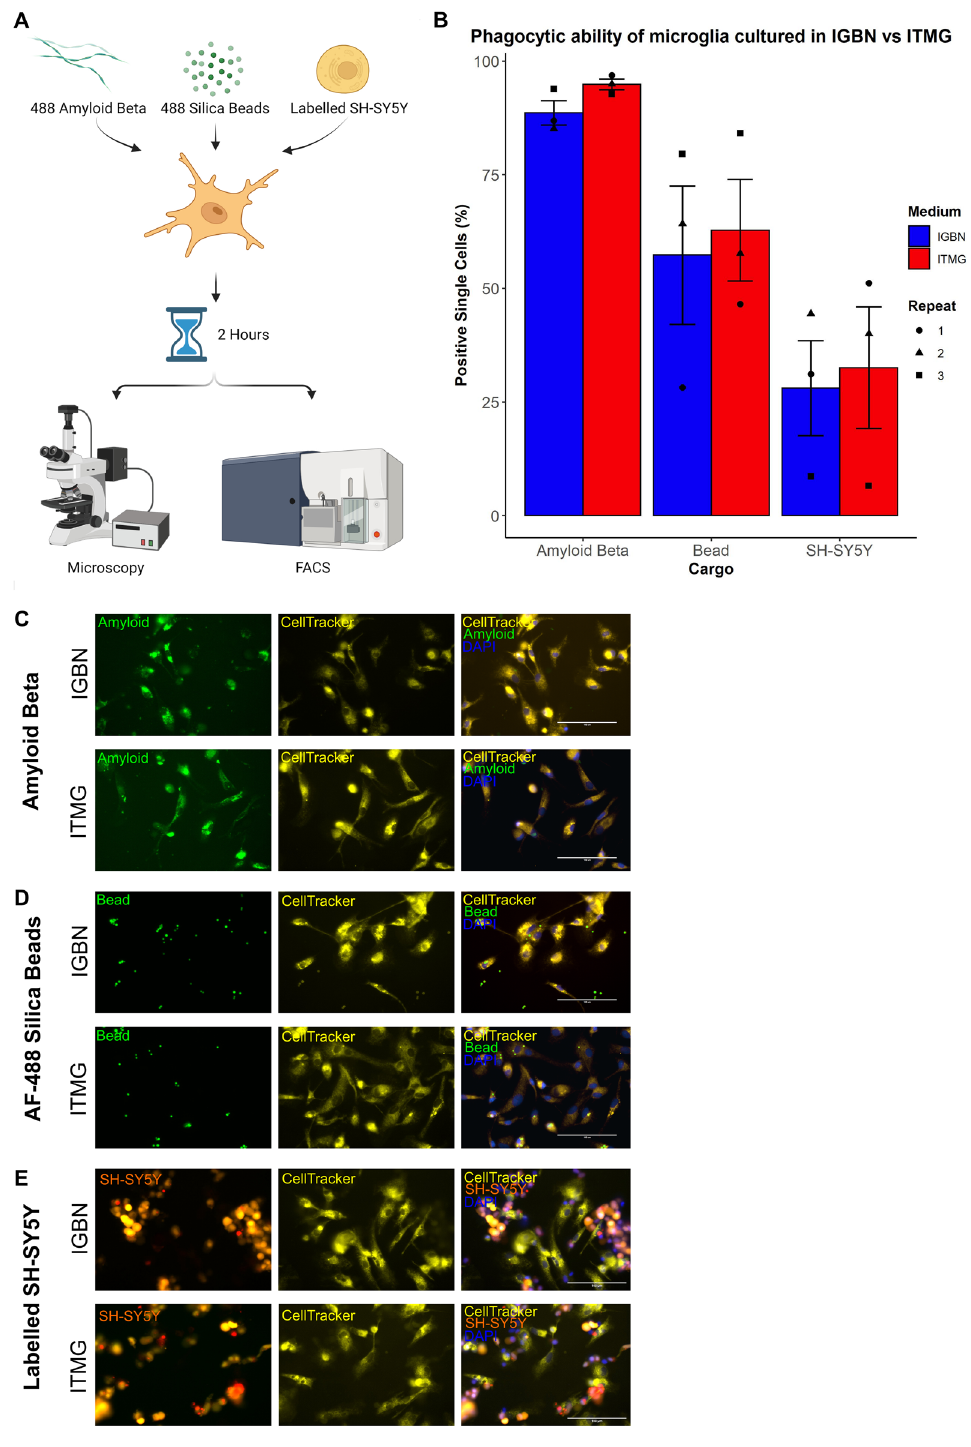
Figure 6. Functional analysis of phagocytosis results in no difference between the new ITMG medium and our previously published IGBN medium. ( A ) To examine phagocytosis in differentiated iPSC-microglia in our new medium, we incubated cells with three different cargos; Amyloid-β aggregates, 488 labelled silica beads, and fluorescent labelled dead SH-SH5Y neuroblastoma. Phagocytosis occurred for 2 h before fixing the microglia and quantifying fluorescence using FACS, and representative images taken by microscopy. Created with BioRender.com. ( B) There is a difference in the phagocytic ability of the different cargos, however there is no difference between the two medium. Data presented as mean ± SEM, N = 3 independent replicates, with individual data points shown. Each independent replicate contained three technical repeats. ( C ) Representative images of Amyloid-β phagocytosis at 2 h. ( D ) Representative images of AF-488 labelled bead phagocytosis at 2 h. ( E ) Representative images of labelled dead SH-SY5Y neuroblastoma phagocytosis is 2 h, red indicates a SH-SY5Y which has been phagocytosed and is in low pH environment. All images are shown at ×40 magnification, microglia are marked with CellTracker, and nuclei are stained with